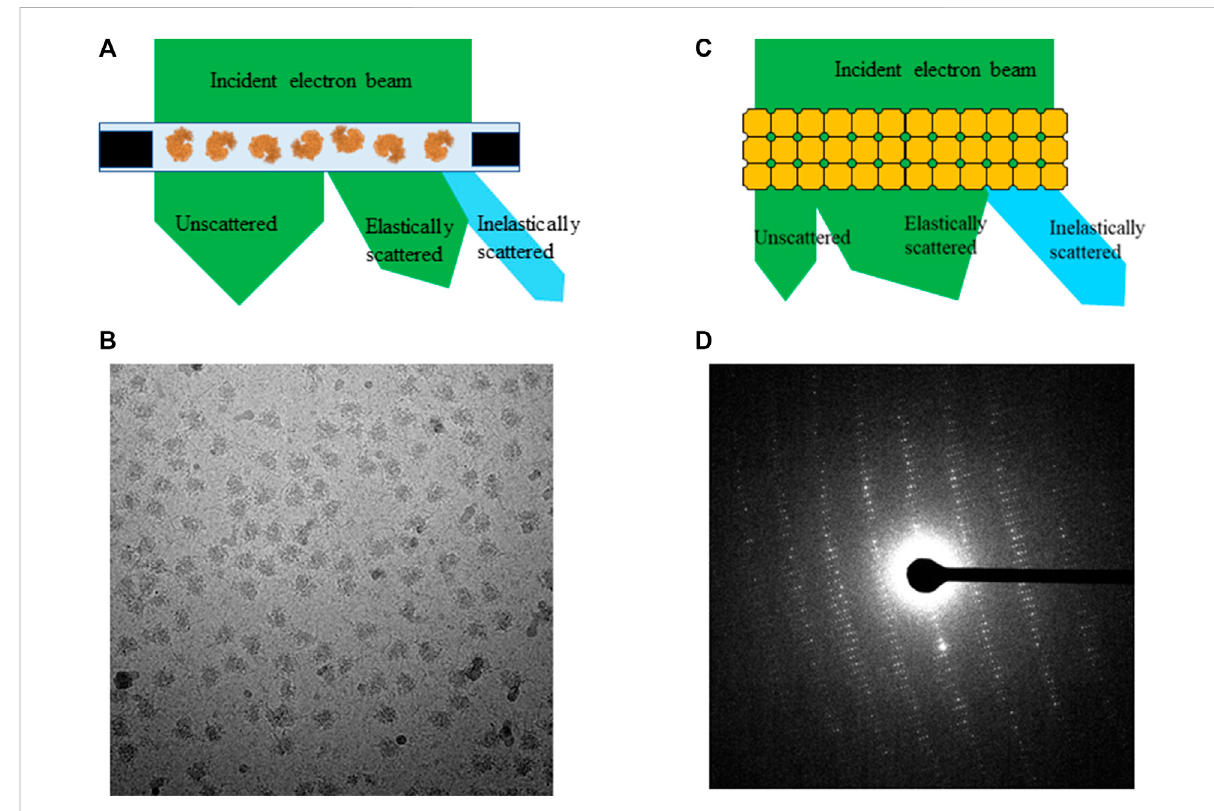
FIGURE 1 An electron beam transmits through (A) frozen-hydrated single particle sample and (C) 3D protein crystal, (B) projection image of single particles and (D) electron diffraction pattern from proteinase K crystal.